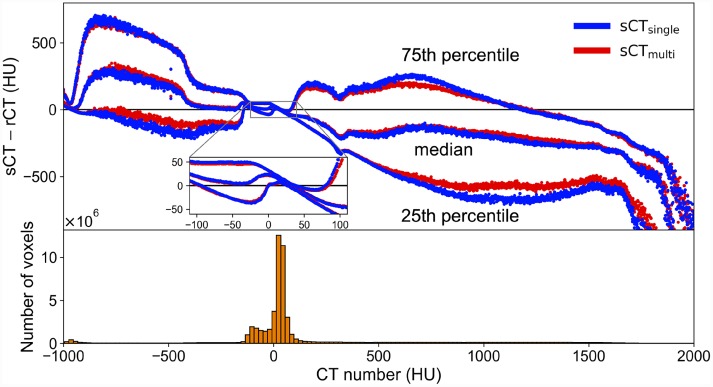
The difference in CT numbers between the synthetic and real CT images (sCT and rCT, respectively). The median, 25th and 75th percentiles of absolute differences (sCT—rCT) are shown with a histogram of the distribution of the voxels inside the patient body contour (bin size, 20). The horizontal axis indicates the rCT CT numbers and the upper vertical axis indicates the absolute difference in CT number. The inset expands the region between −100 and 100 HU, which included more than 70% of all the voxels. In this region, the median differences were within ±50 HU.